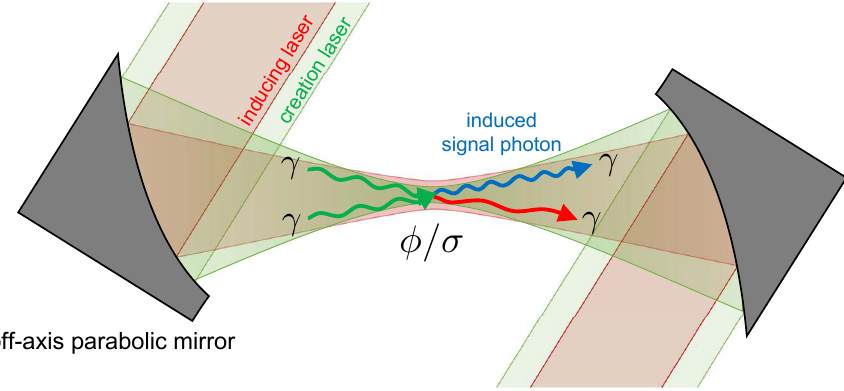
Figure 1 . Concept of a stimulated resonant photon-photon collision (vFWM process) via scalar ( φ ) or pseudoscalar ( σ ) fields. The coaxially combined green and red lasers, which are, respectively, used to create ALPs and to simultaneously induce those decays, are focused with a parabolic mirror in a vacuum. The wavy arrows represent two-body photon-photon scattering via ALP exchange in the laser fields. The induced signal photons with wavelength determined by energy-momentum conservation (blue arrow) are produced primarily around the focal